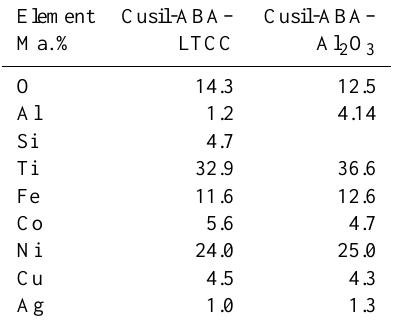
Table 3. Compositions of interfacial reaction layers Cusil-ABA– LTCC at 830 ◦ C for 10min and Incusil-ABA–LTCC after brazing at 755 ◦ C for 10min.